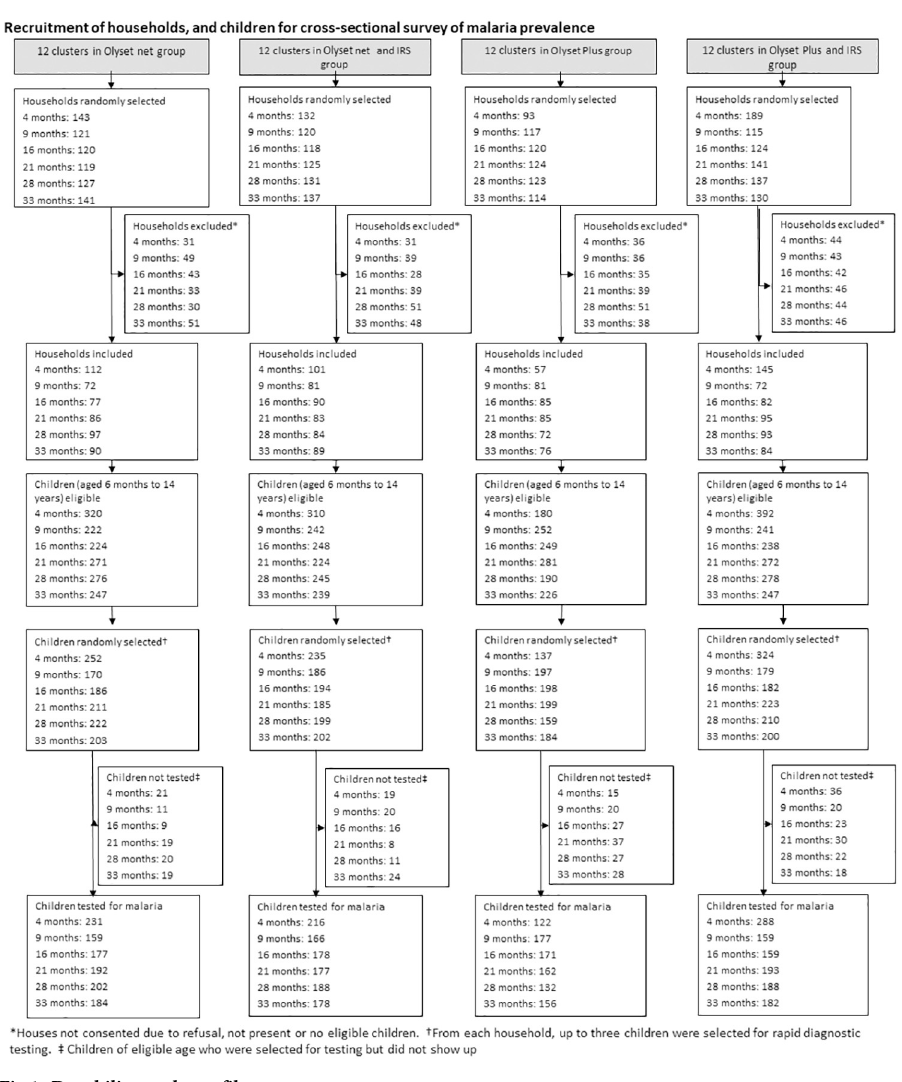
Fig 1. Durability study